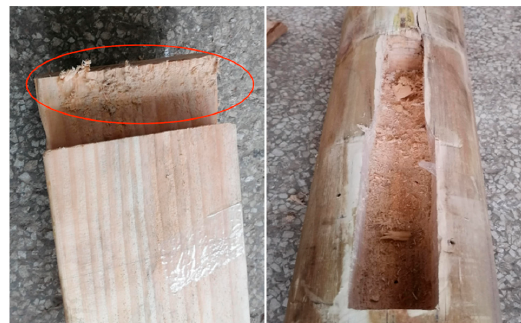
Figure 9. Wear of dovetail tenons and mortises.